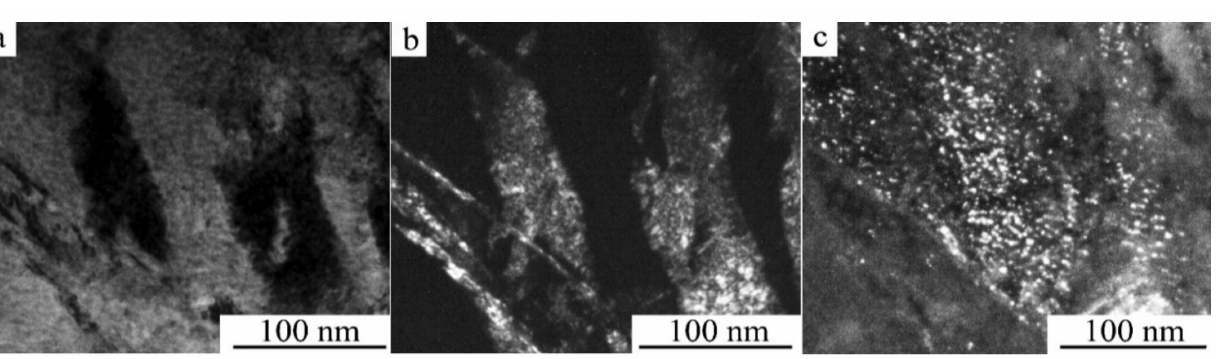
Figure 14. ( a ) Bright- and ( b , c ) dark-field TEM images of the aging martensite microstructure in the coarser grain of the Cu-14Al-3Ni alloy after the HPT of 10 revs and isochronous anneals (for 30 min) at 373